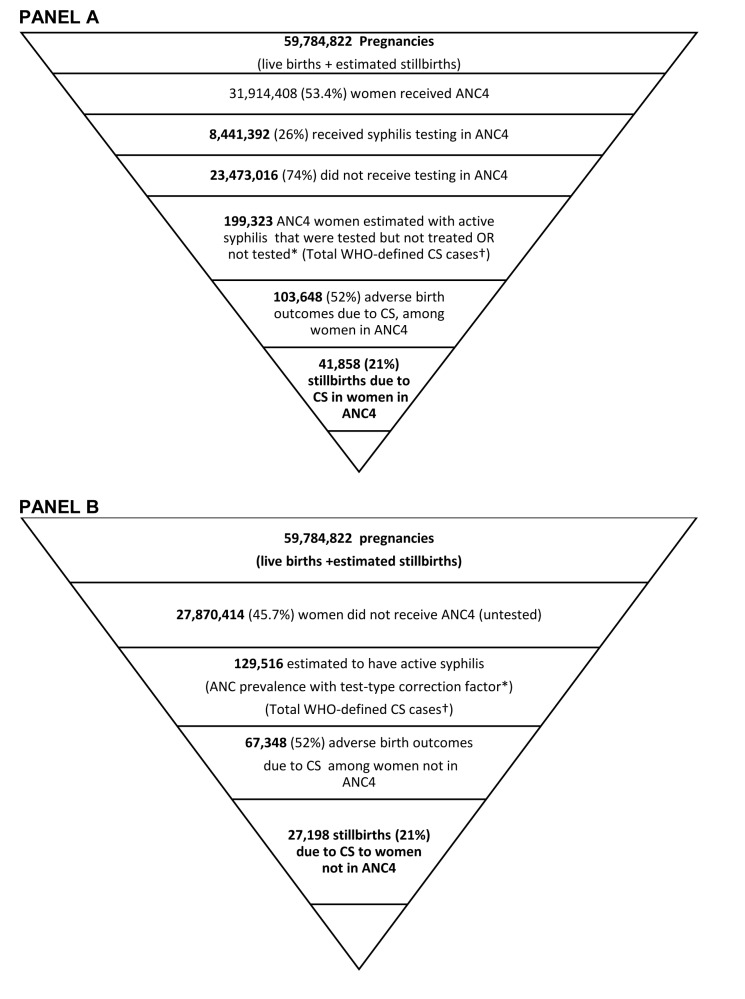
Estimated congenital syphilis cases associated with missed opportunities for testing and treatment. Panel A. Receipt of Antenatal Care, at least four visits (ANC4). *Test type correction factor applied to percent testing positive and ANC women untested but assumed positive based on prevalence of tested proportion. Panel B. No receipt of ANC. *The same test-type correction factor applied for this proportion of women not attending ANC4 as was applied for those in ANC4. Country-reported maternal syphilis prevalence of women in ANC applied to this calculation (GAM). †The WHO global surveillance case definition for congenital syphilis is A live birth or fetal death at >20 weeks of gestation or >500 g (including stillbirth) born to a woman with positive syphilis serology and without adequate syphilis treatment” [6].